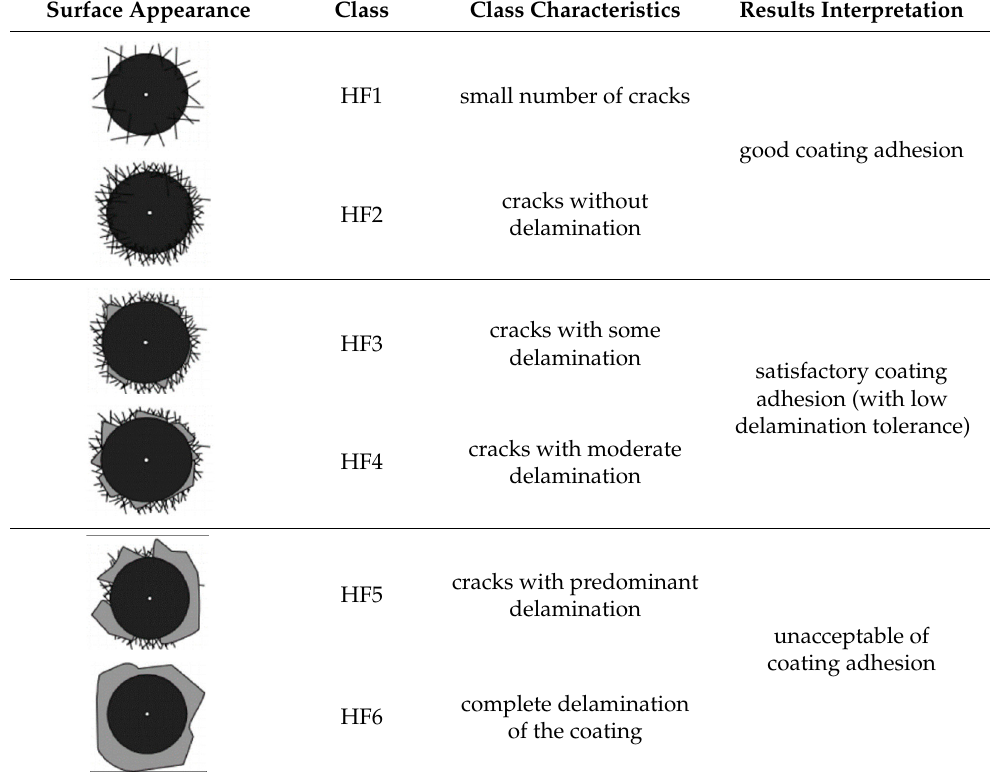
Figure 22. Coating surface around indentation and corresponding adhesion class of coated sample: ( a ) SH-5-TiBN; ( b ) SH-15-TiBN. The scratch test allows for the quantification of the coating adhesion by registering the characteristic delamination forces during pulling a diamond cone at a constant speed with a linear increase of force. As expected, the TiBN coated samples showed excellent properties in terms of coating adhesiveness. Both of the tested samples, regardless of the cobalt content, withstood a maximum force of 50 N without the appearance of cracks and separation of the coating (Figure 23); hence, the characteristic forces L c1 L c2 and L c3 could not even be measured. Therefore, this type of coating and coating process can be considered to be very successful.